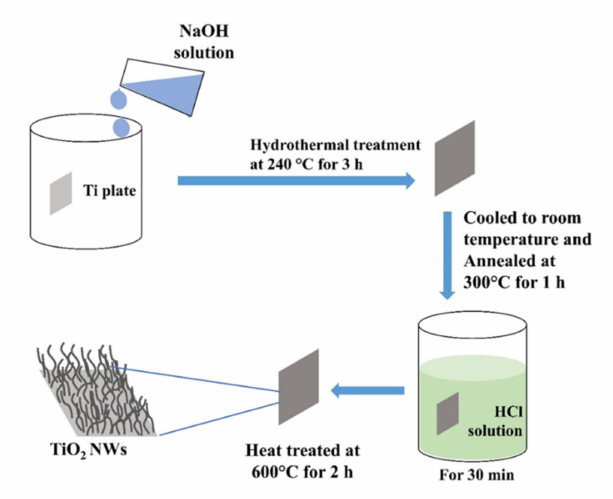
Figure 3. Hydrothermal method for obtaining TiO 2